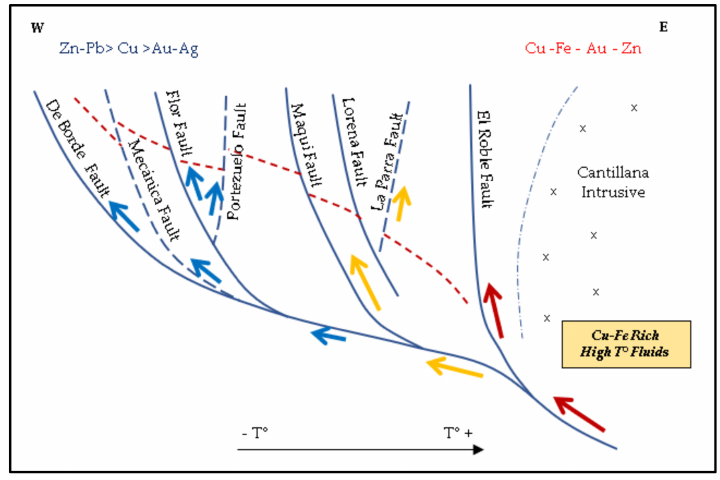
Figure 4. Schematic flow model of mineralizing solutions, Alhu é district [9].